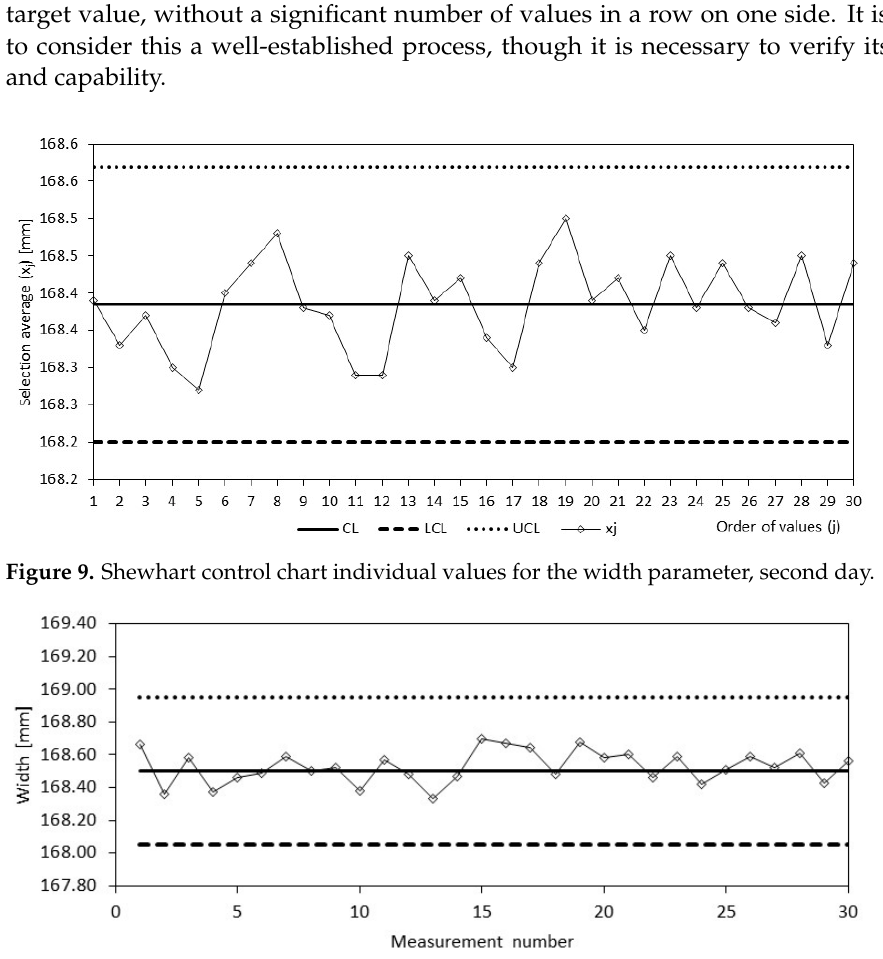
Figure 10. Measured data for the width parameter, third day.